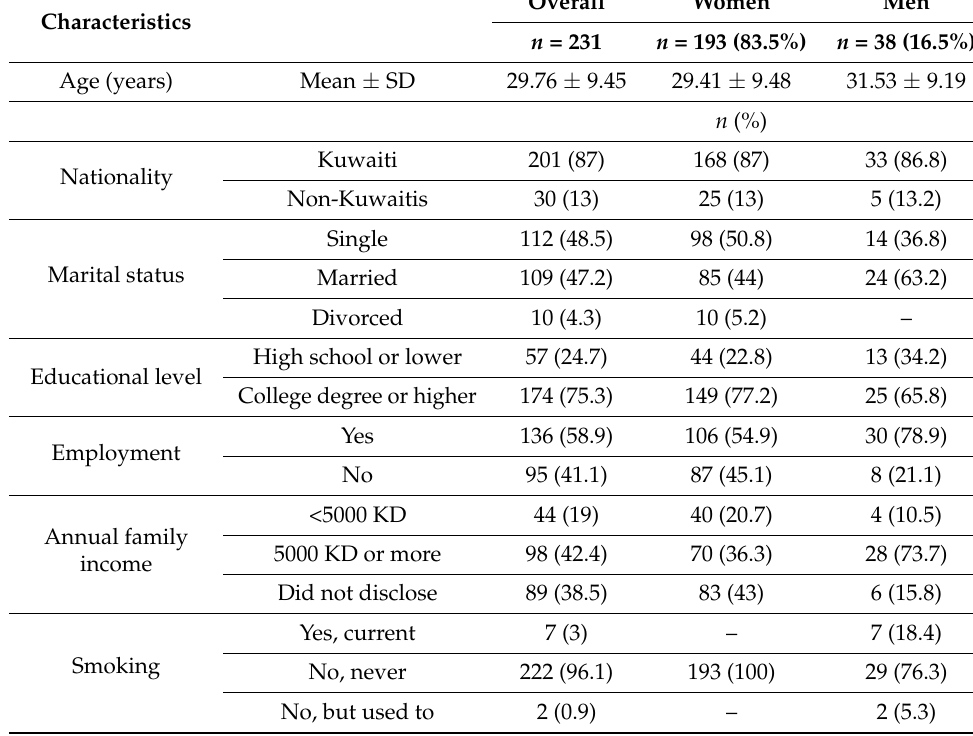
Table 1. Participant